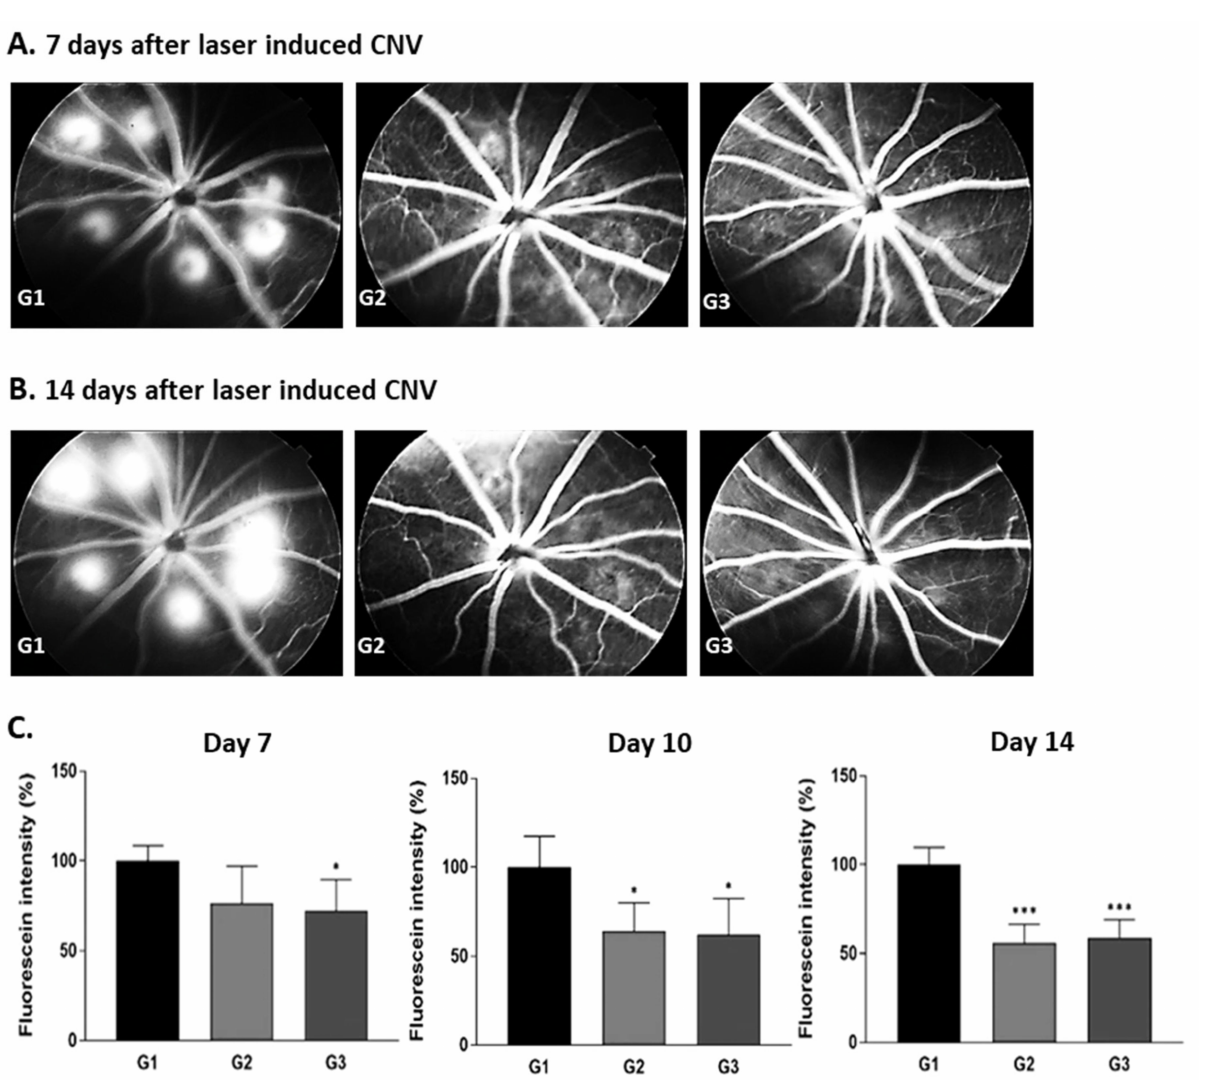
Figure 3. The effects of the intravitreal administration of Ac-RLYE and aflibercept on inhibition of choroidal neovasculariza- tion (CNV) in laser-induced CNV rat models with treatment of peptide or aflibercept at the same day as laser irradiation. The intensity of laser irradiation and spot size was empirically set to maintain the retinal fluorescence intensity in the vehicle treatment group at 2 weeks after laser irradiation. ( A , B ): Representative retinal fluorescence fundus image. ( C ): A quantitative image analysis result for retinal fluorescence intensity using the ImageJ software ( n = 6 rats per group). The day of laser irradiation was designated as day 0. Data are expressed as mean ± S.D. G1: Vehicle control, G2: Aflibercept 400 µ g/10 µ L/eye, G3: Ac-RLYE 20 µ g/50 µ L/eye. ***/* A significant difference at p < 0.001/ p < 0.05 level compared to the G1. Compared to vehicle group (arbitrarily set at 100%, G1), the retinal fluorescence intensity of Ac-RLYE treated group (G3) was significantly different from day 7 after laser irradiation, whereas that of the aflibercept treated group (G2) was significantly decreased from day 10 after laser